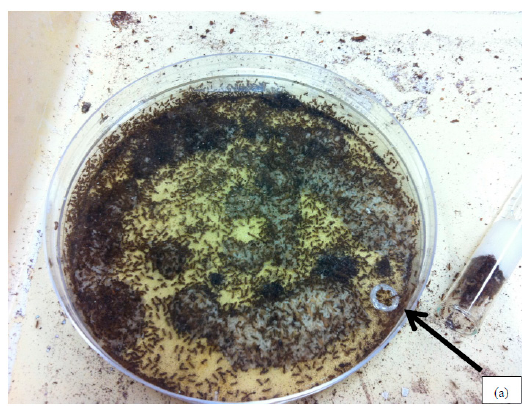
Figure 1. Artificial nest for laboratory maintained Nylanderia fulva colony fragments. The artificial nest consists of a plastic petri dish (100 × 15 mm) filled three-quarters with dental plaster. A hole (a) melted into the petri dish cover allowed ants to access to the interior of the nest.